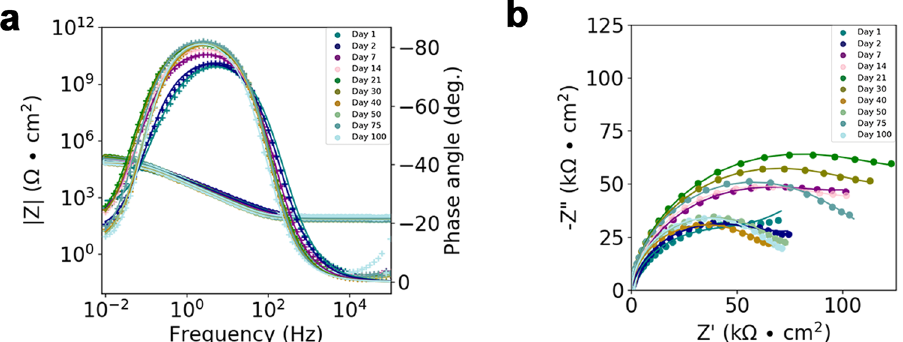
Fig. 4 Plots Depicting the Evolution of EIS for Bare AA 7075. Bode ( a ) and Nyquist ( b ) plots for AA 7075 for a 100 day exposure to an aqueous solution of 3.5 wt.%